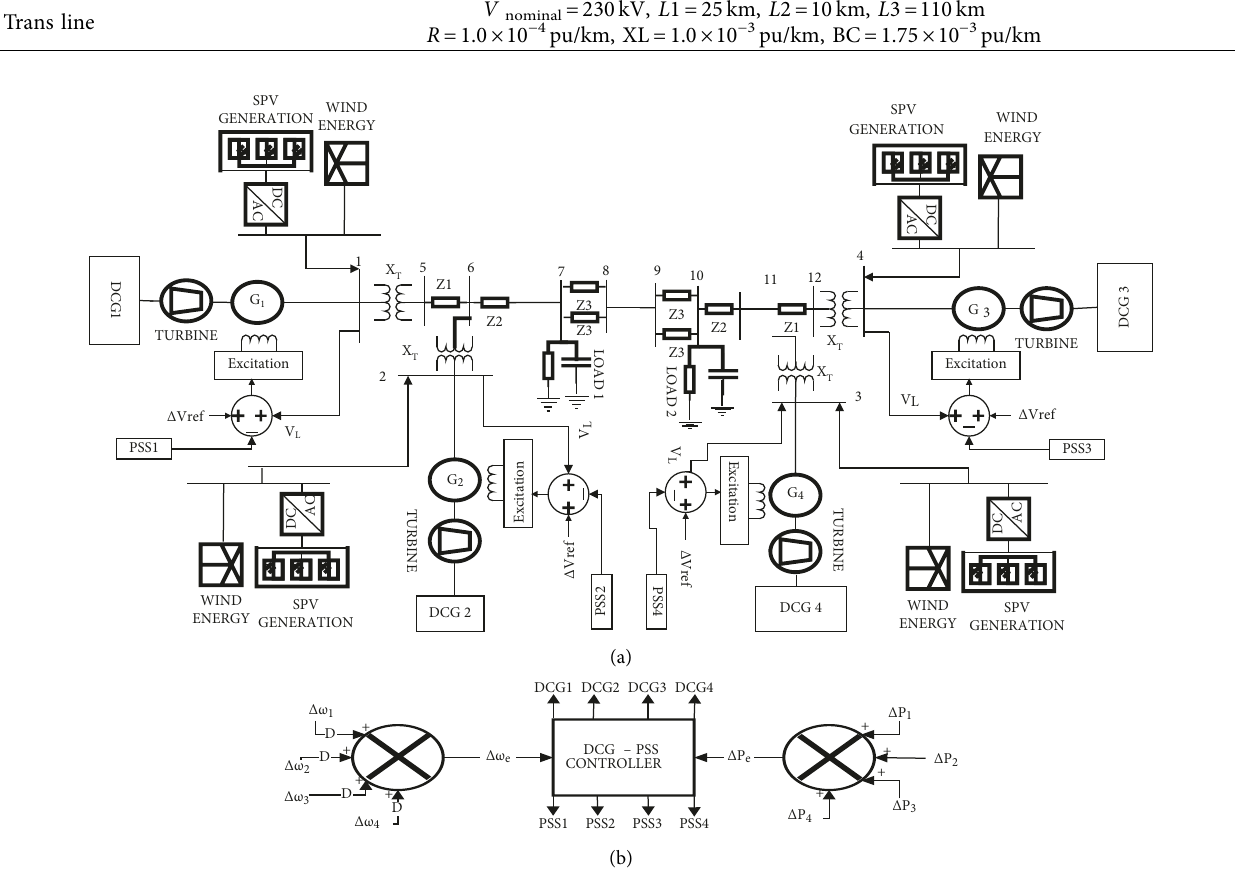
Figure 9: (a) Two area system under study. (b) Control unit Table 3: Initial operating condition for hydro generators for four m/c system.